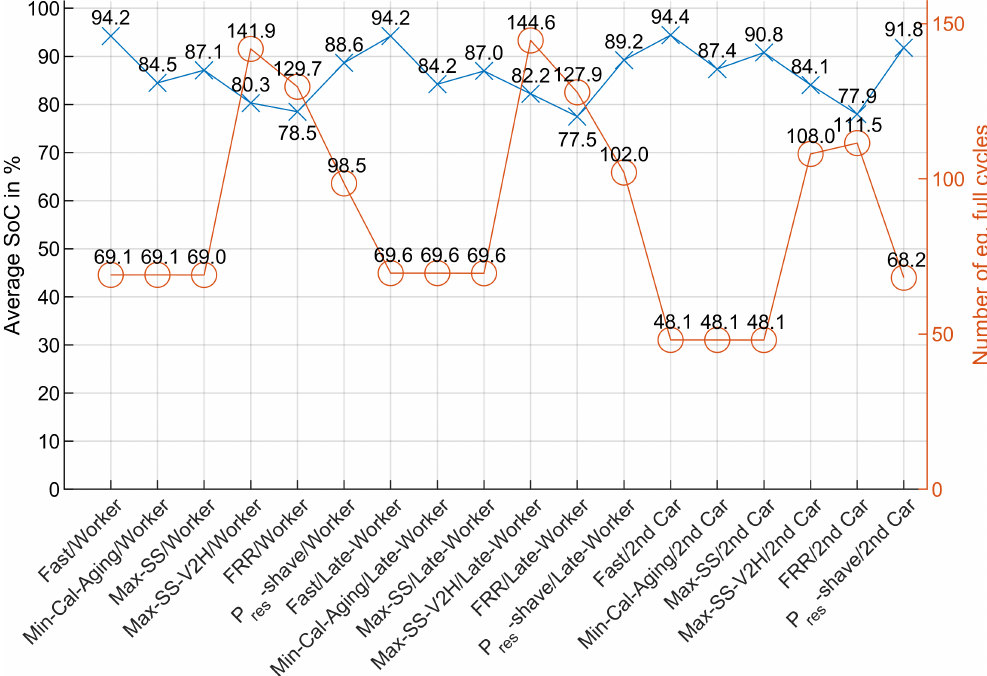
Figure A11. Average SoC and number of eq. full cycles for scenario home and workplace charging H + W and no SoC V 2 XLimit